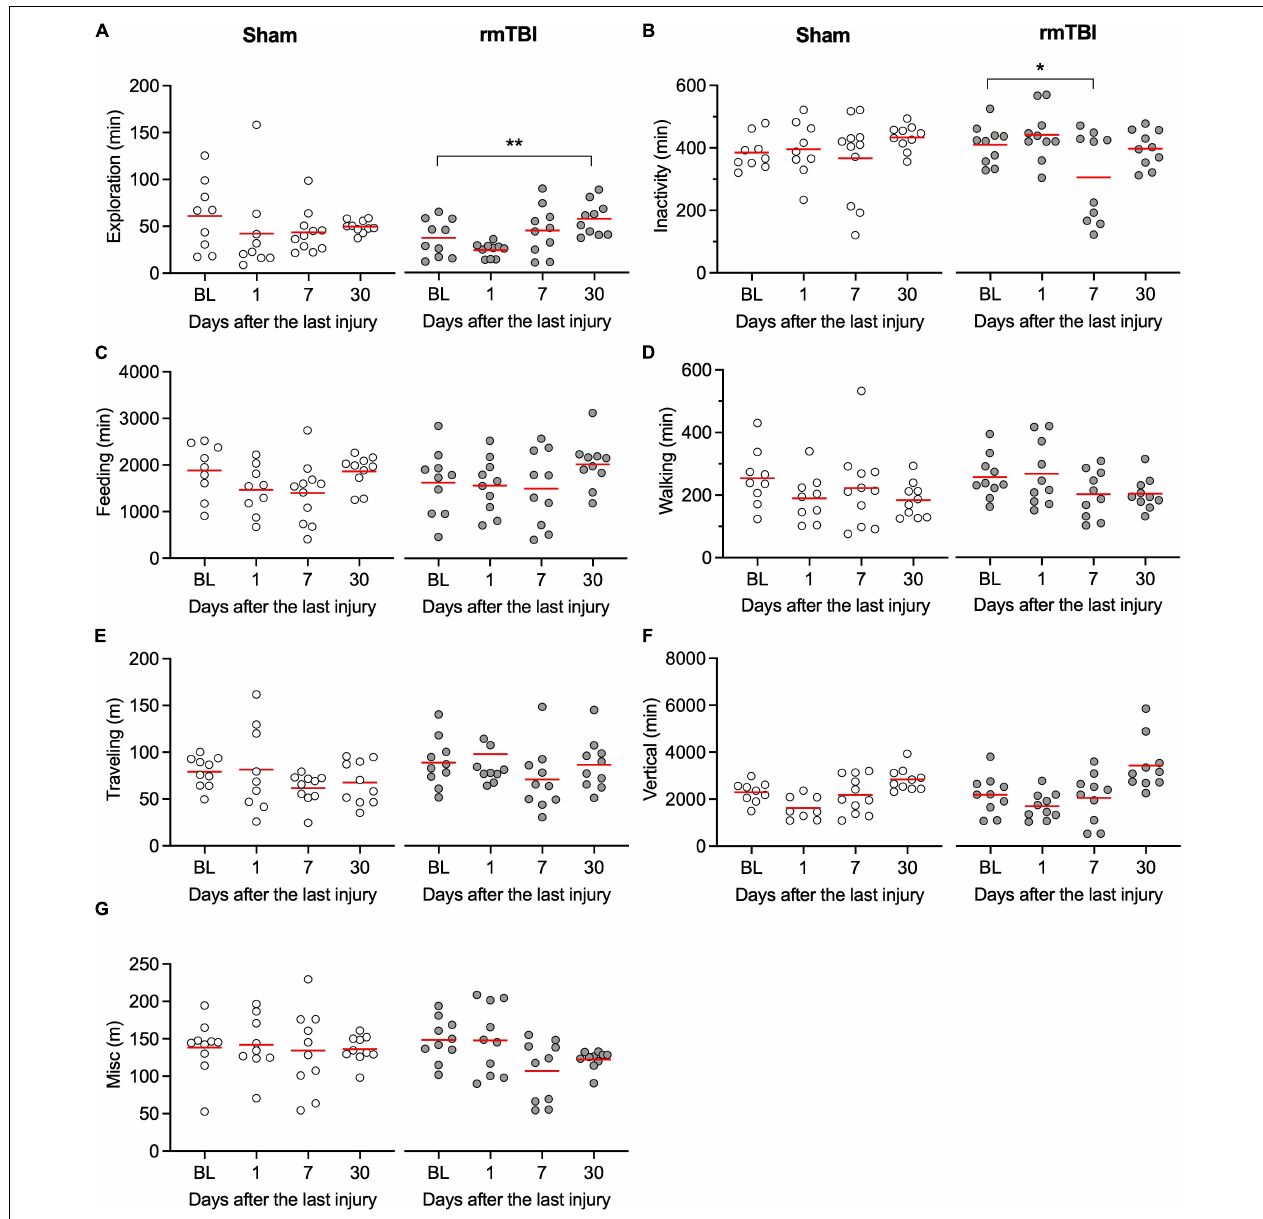
FIGURE 4 | rmTBI on behaviors in home-cage scanning system test. (A) Rats with mTBI spend more time on exploration 1 month after injury. (B) Rats with injury experience transient reduced activity 7 days after injury. Rats with rmTBI don’t show change in feeding (C) , walking (D) , traveling (E) vertical behavior (F) , and all other behaviors (G) . * P < 0.05, ** P < 0.01 by the Tukey test following one-way repeated-measures ANOVA. Each dot represents data from one